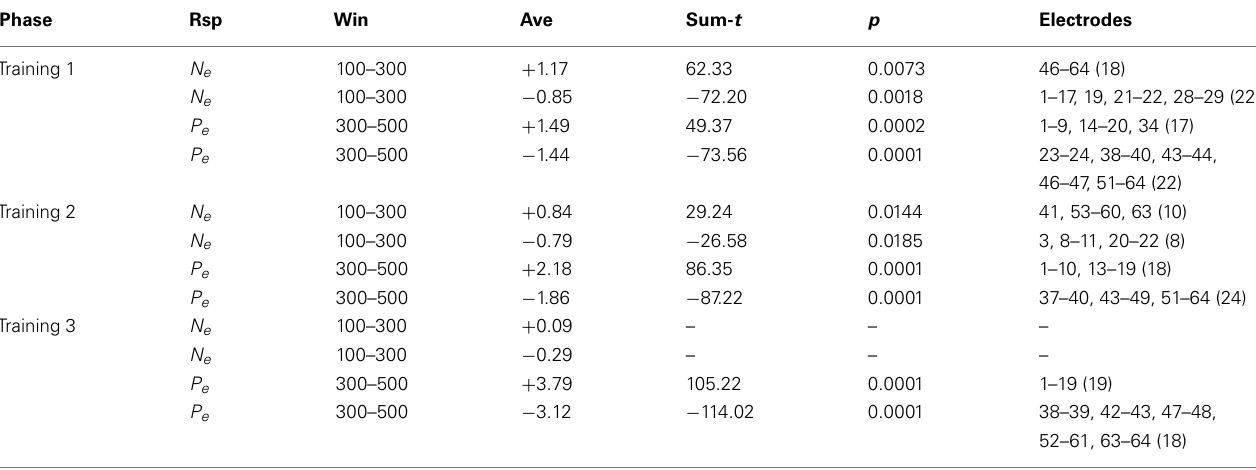
Table 4 | Statistics for feedback error-related EEG activity (Rsp) in the three training